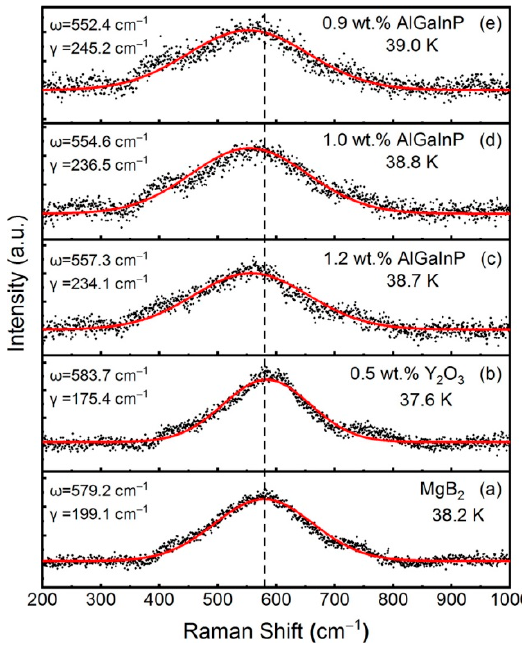
Figure 8. Raman spectra of ( a ) pure MgB 2 and MgB 2 doped with ( b ) 0.5 wt.% Y 2 O 3 , ( c ) 1.2 wt.% AlGaInP, ( d ) 1.0 wt.% AlGaInP, and ( e ) 0.9 wt.% AlGaInP. (2) Performance improvement of smart meta-superconductor Because the p-n junction inhomogeneous phase exhibits good behavior under external field excitation, the optimal amount of the dopable inhomogeneous phase increases from 0.5 wt.% to 1 wt.% compared with oxide. Thus, the critical temperature Tc , current density Jc and the Meissner effect of superconductor can be improved compared with the oxide inhomo- geneous phase, which provides a wider range for the adjustment of material properties. In particular, the performance stability of the material has been greatly improved, and can be stable for more than several hundred hours. The doping of AlGaInP with too large or too small particle sizes even decreased the T C of MgB 2 . Therefore, selecting AlGaInP with a suitable particle size is also an important factor to improve the T C . However, Al- GaInP particles with a uniform size cannot be obtained by the current preparing process. Improving the preparation process to obtain AlGaInP particles with a uniform size is a focus in our follow-up work. (3) The origin of smart superconductivity In order to explain the above experi- mental results, we propose an explanatory view of smart superconductivity. Figure 9 shows the schematic diagram of smart superconductivity. By introducing the p-n junc- tion electroluminescent inhomogeneous phase, the photon generated by the inhomoge- neous phase in the external field interacts with some superconducting electrons to pro- duce surface plasmon polaritons. The generated evanescent wave can transmit a large number of superconducting electrons with the same energy unimpeded, resulting in the surface plasma system to promote the intense interaction of electrons. The energy injec- tion improves the electron pairing state, promote the superconductivity behavior of the material, increases the critical transition temperature, and forms smart superconductivi- ty.